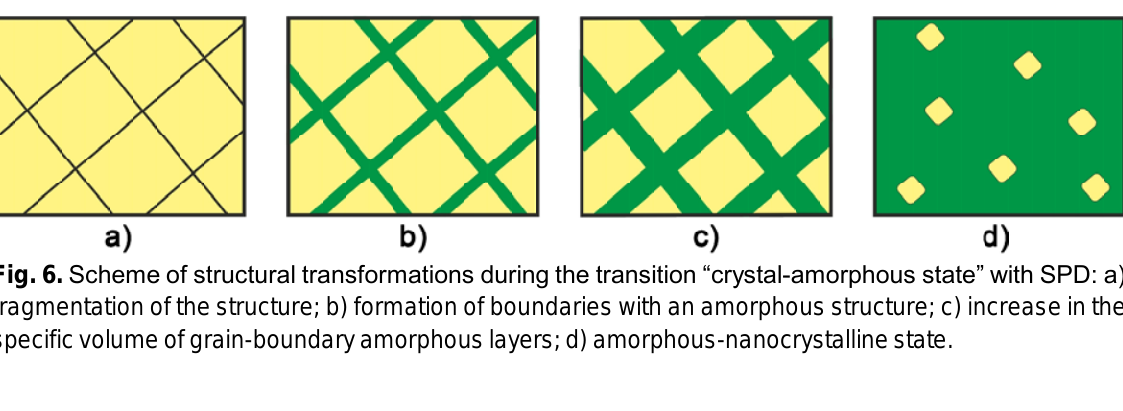
Fig. 5. Electron microscopic image of Ti alloy structure in direct mode after HPT ( n = 1/2); CR - crystalline phase; GB is the grain boundary region in the amorphous state.